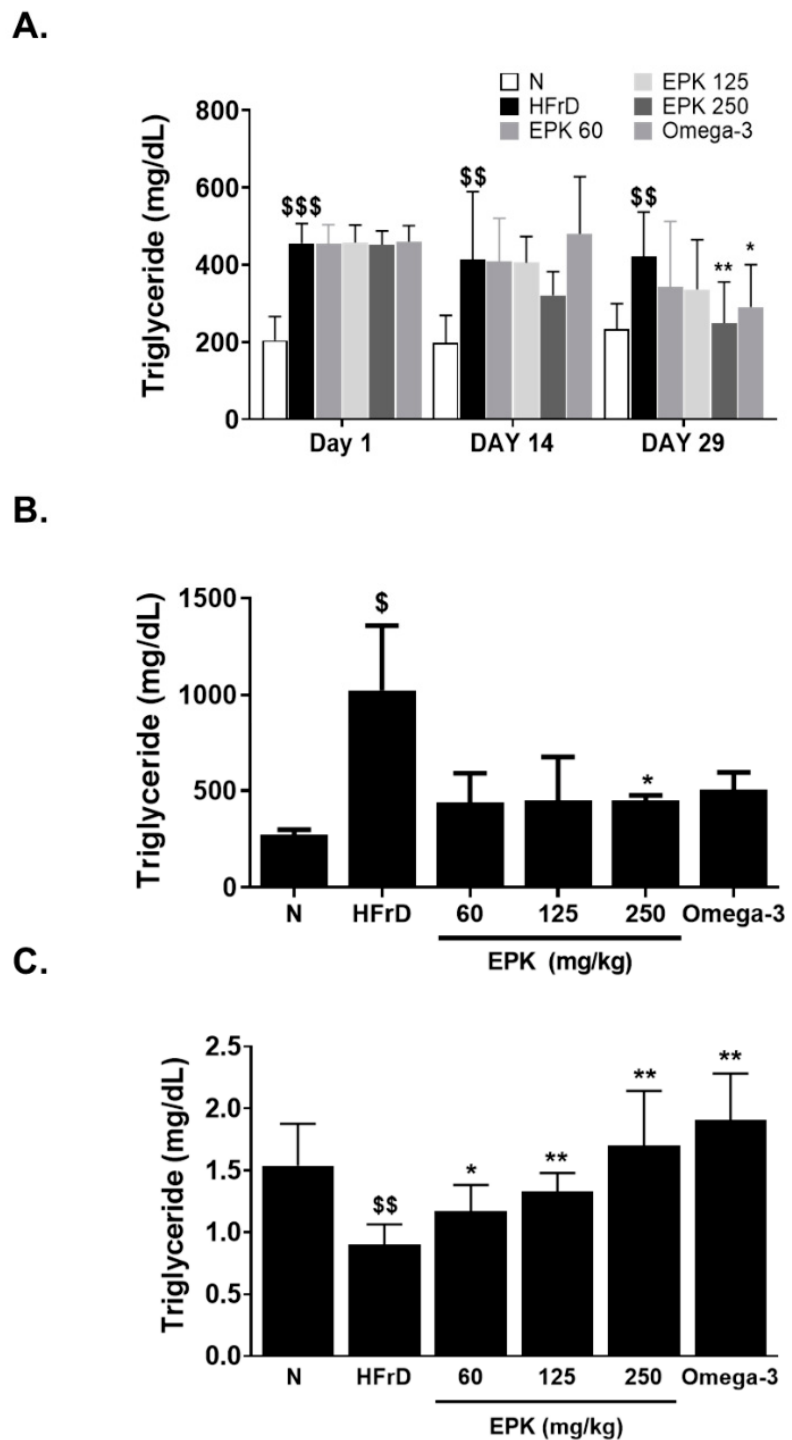
Figure 1. Effect of EPK on triglyceride levels (TG) in HFrD rat model. ( A ) Serum TG level measured every two weeks. ( B ) Liver TG level. ( C ) Fecal TG level. Data are expressed as mean ± SD. * p < 0.05 and ** p < 0.01 versus HFrD control group. $ p < 0.05, $$ p < 0.01, and $$$ p < 0.001 versus normal group.